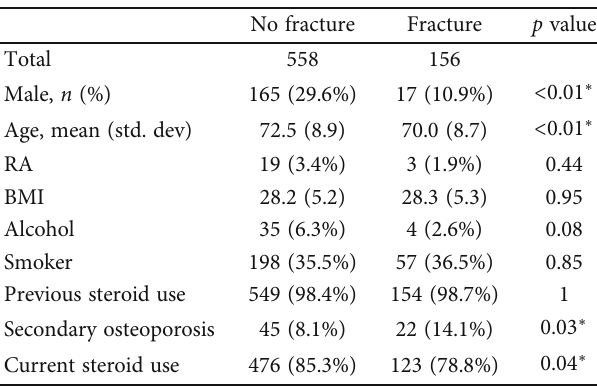
Figure 1: Diagram showing di ff erent geometric parameters measured from 2-dimensional DEXA images in hip structural analysis. Table 1: Descriptive data of patients with polymyalgia rheumatica with and without